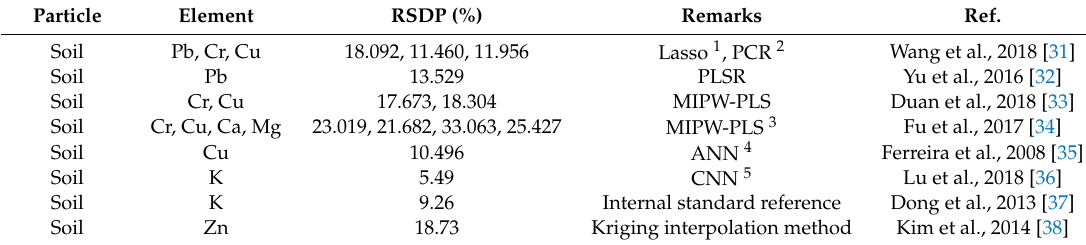
Table 5. Related literature of detection of main metals in soils using